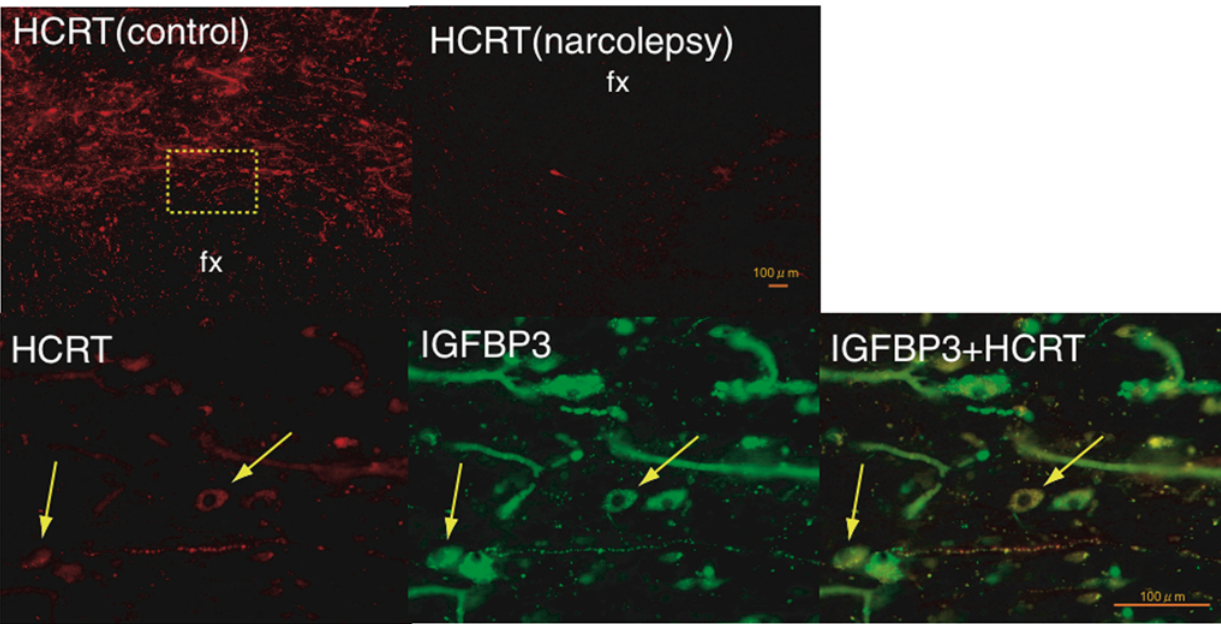
Figure 2. Colocalization of IGFBP3 in HCRT cells in control and narcolepsy human brain. Upper panel: Distribution of hypocretin cells and fibers in the perifornical area of human hypothalamus. (A) In control brains, HCRT cells and fibers were densely stained by an anti-HCRT monoclonal antibody (red fluorescence: VectorRed), while in narcolepsy brains, staining was markedly reduced (B) Lower panel: HCRT immunoreactivity (C: red fluorescence) and IGFBP3 immunoreactivity (D: green fluorescene; Q-dot525) and a composite picture (E) arrows indicate HCRT cells colocalized with IGFBP3). Note non-neuronal autofluorescent elements. Scale bar: 500 m m in A and B, 100 m m in C, D and E.